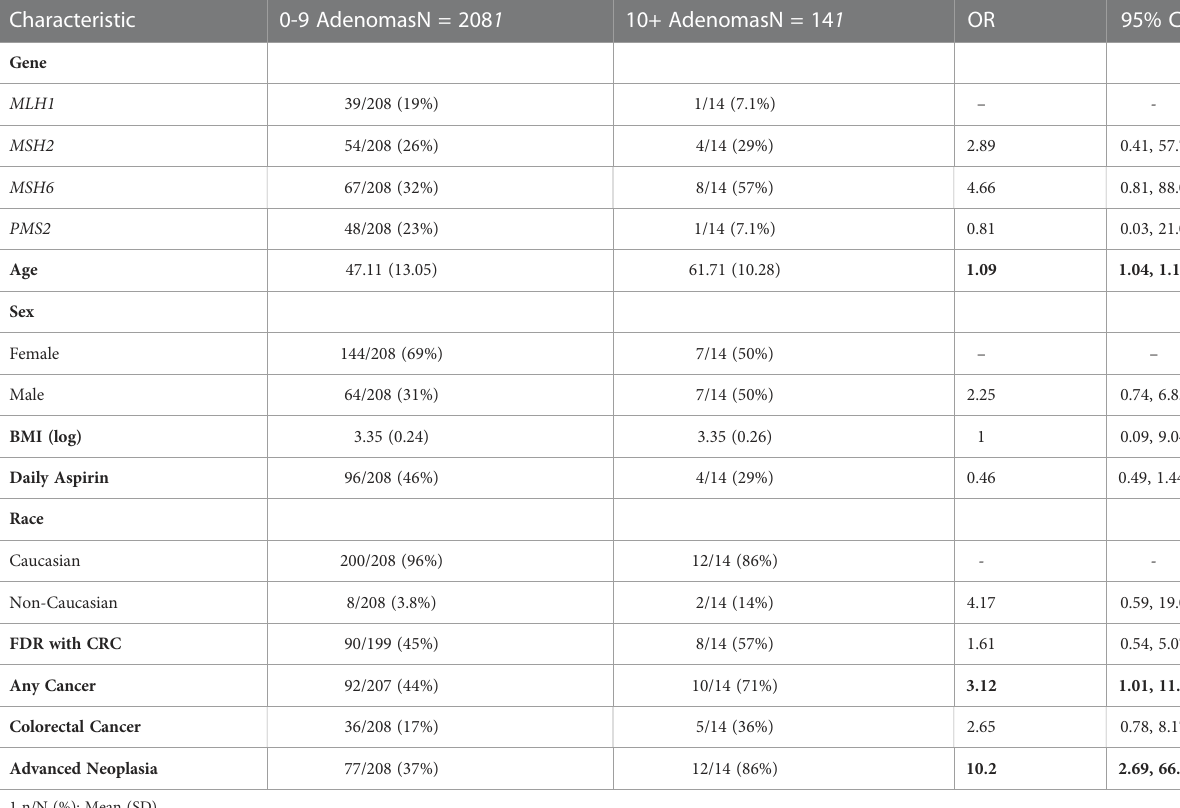
TABLE 2 Univariable analysis of patients with adenomatous oligopolyposis.